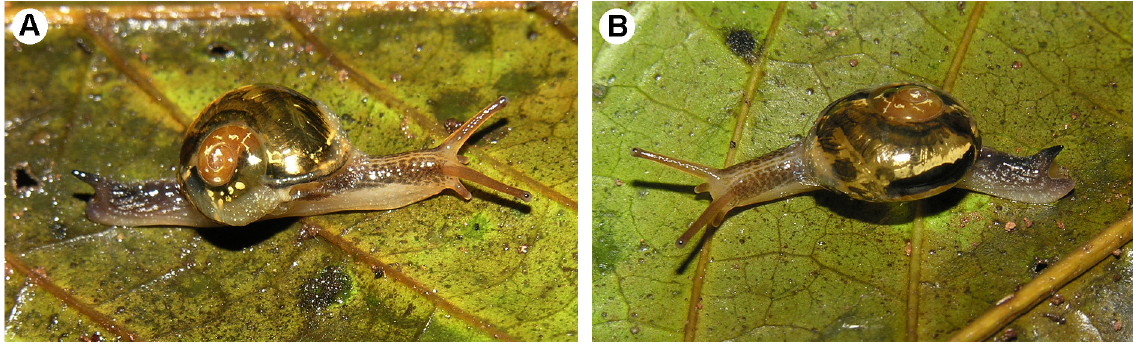
Fig. 14. Sheldonia wolkbergensis sp. nov., holotype, shell diameter 7.7 mm